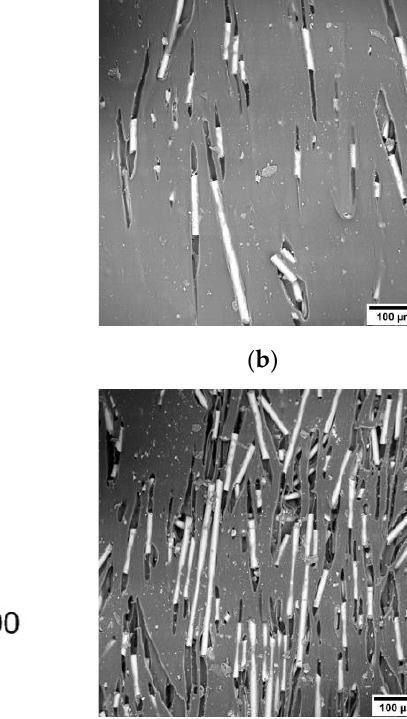
Figure 2. Stress-strain curves for samples with different GS content ( a ) and SEM images of the surface of samples with 10 ( b ), 31 vol.% ( c ) GS.